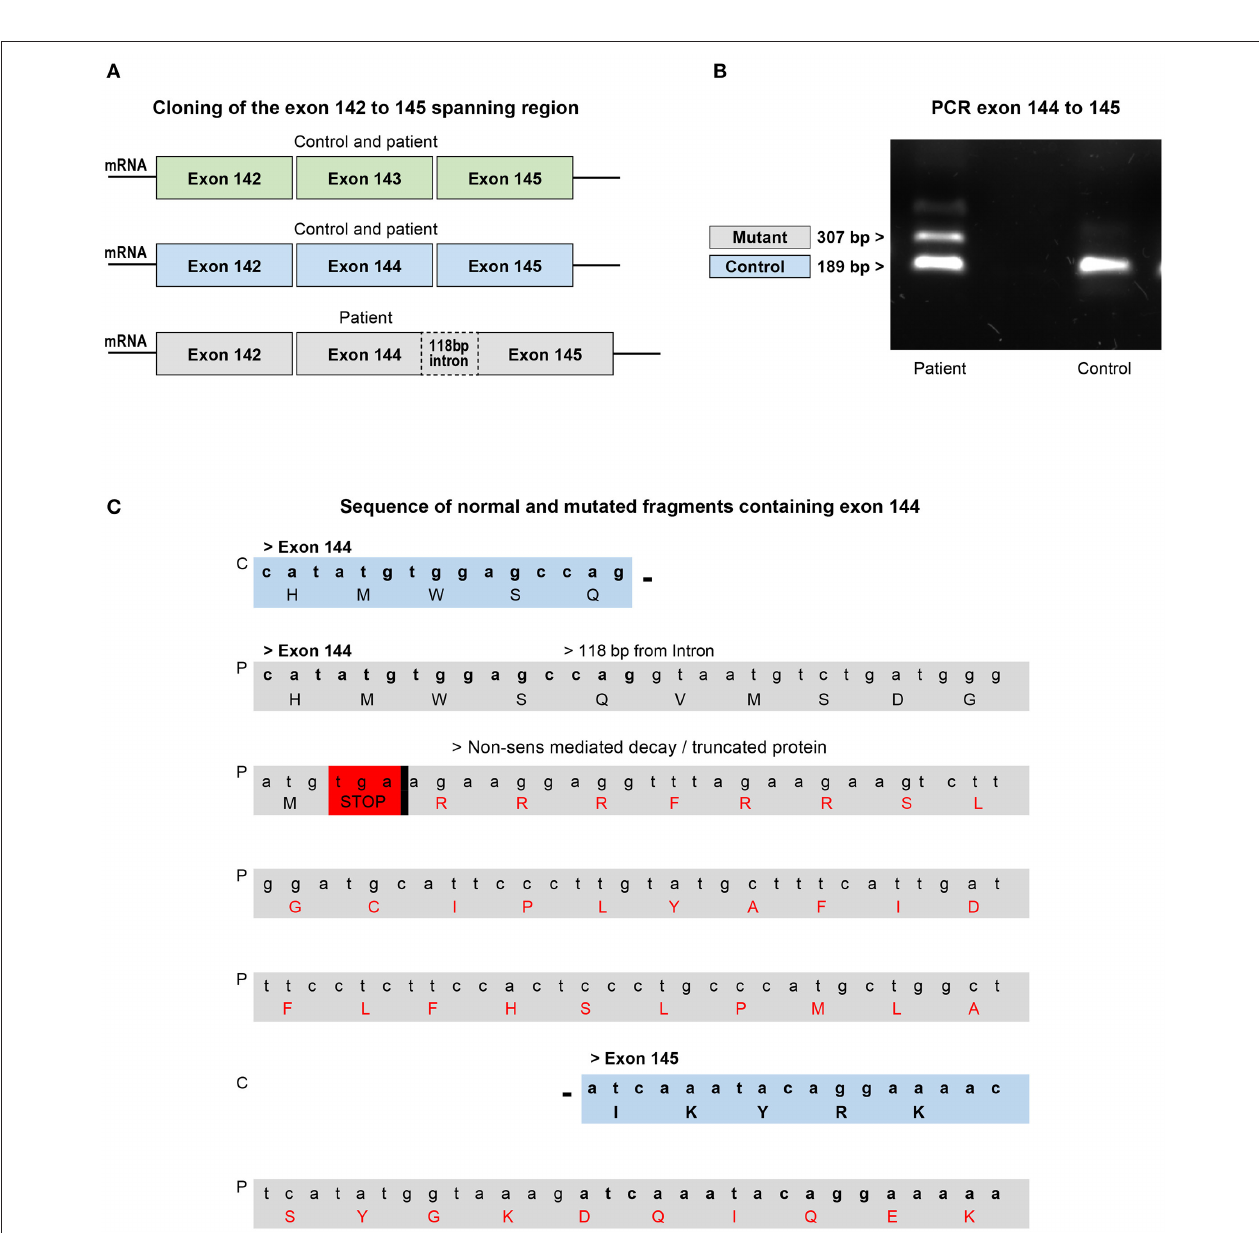
FIGURE 5 | Analysis of cloned fragments ranging from exons 142–145 from the patient’s biopsy or skeletal muscle control RNA. (A) Fragments with or without exons 143 and/or 144 found in the control and patient’s biopsy. (B) Electrophoresis analysis of the PCR fragment of the exons 144–145 shows the presence of an additional band in the patient which corresponds to the intron containing fragment found in the biopsy. The smaller fragment found in both control and patient corresponds to the normal exons 144–145 region. (C) Comparison of part of the sequence of the normal and intron containing fragments with exon 144. The mutation disrupts the reading frame by introducing a premature termination codon that targets the mRNA for degradation or production of a truncated protein. C, control; P,